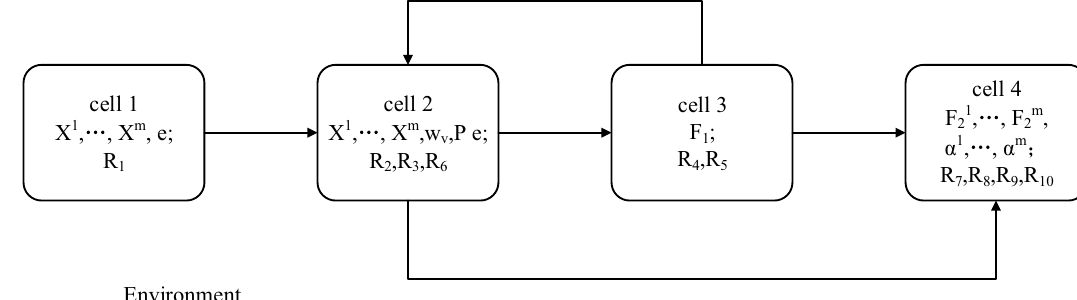
Figure 2. The basic framework of tissue-like P